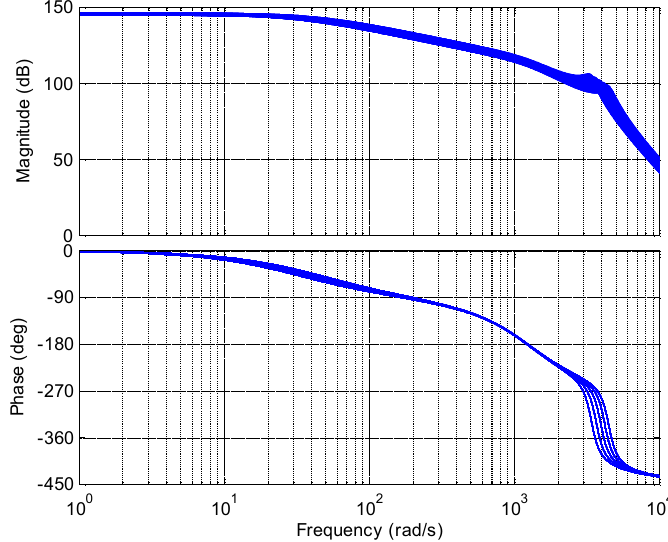
Figure 4. Frequency characteristics of equivalent model set.